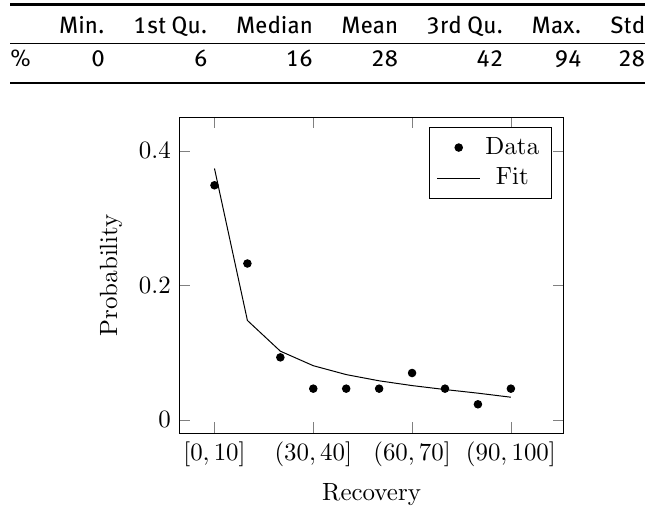
Figure 8: Recovery data and Beta-binomial fit. Thedatapointsrepresentthenumberofcrediteventsleadingtolossesineach10%intervaldividedbythetotalnumberofevents, and the solid line is the result of a Beta-binomial